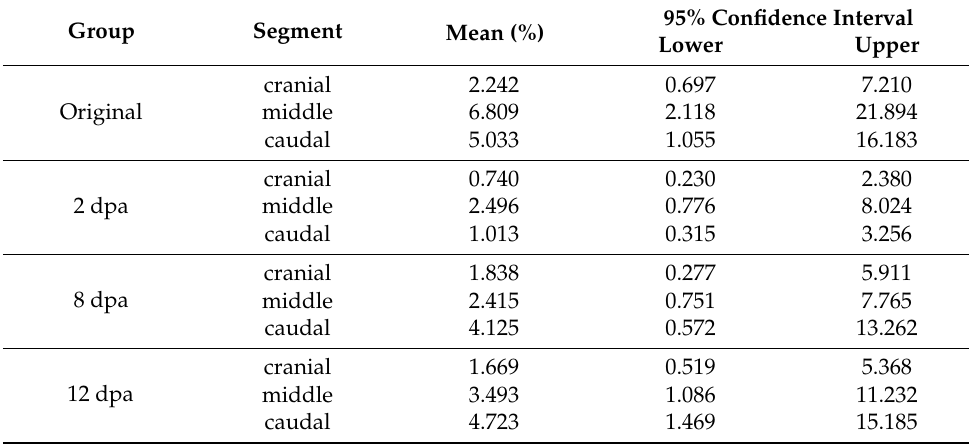
cranial 0.740 0.230 2 dpa